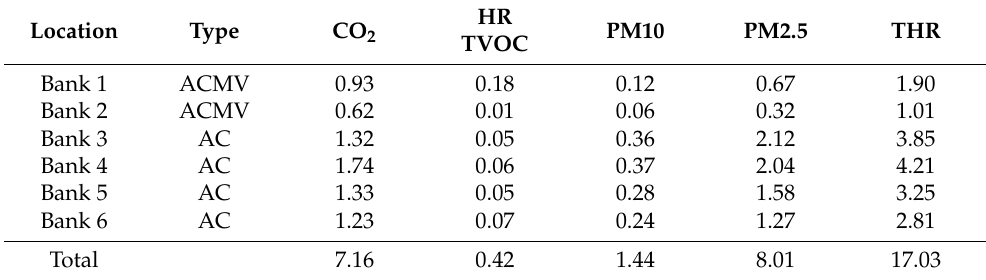
Table 7. Hazard ratio in operation